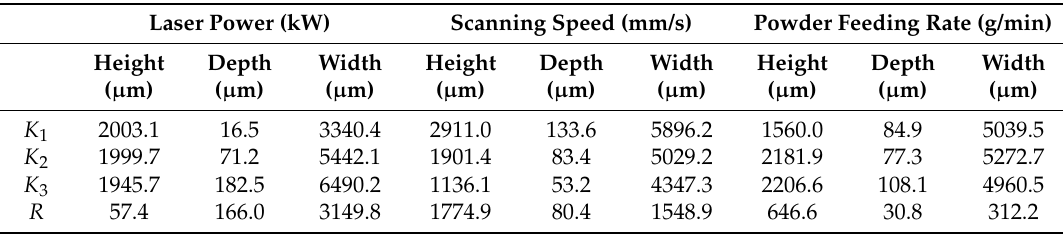
Table 4. Range analysis data sheet.